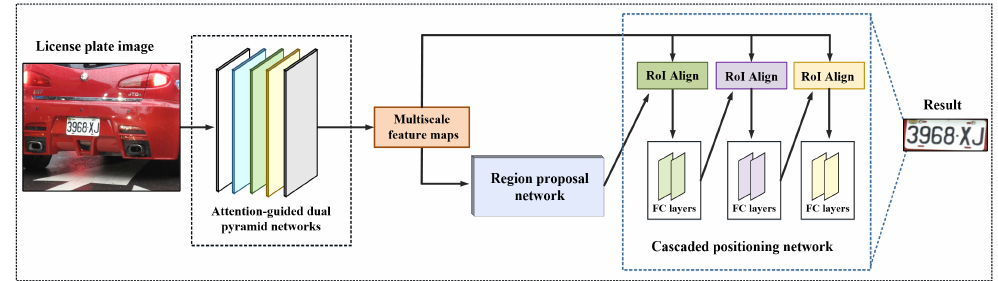
Figure 1. Illustration of the proposed